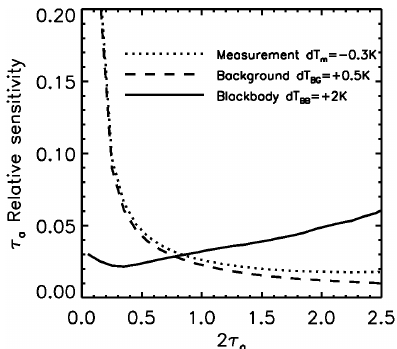
Figure 1. Relative sensitivity of absorption optical depth τ a to vari- ations of measured (dotted), background (dashed), and blackbody (solid) brightness temperatures d T m =− 0.3K, d T BG = 0.5K, and d T BB = 2K,